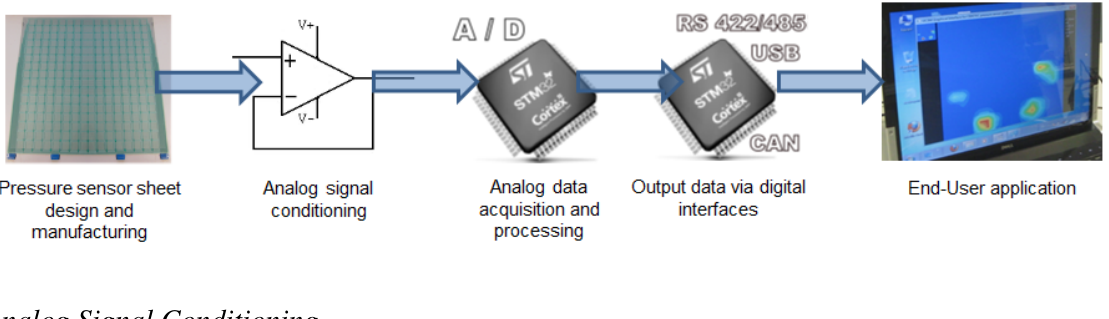
Figure 5. Integration stages, from pressure sensor sheet to an useful